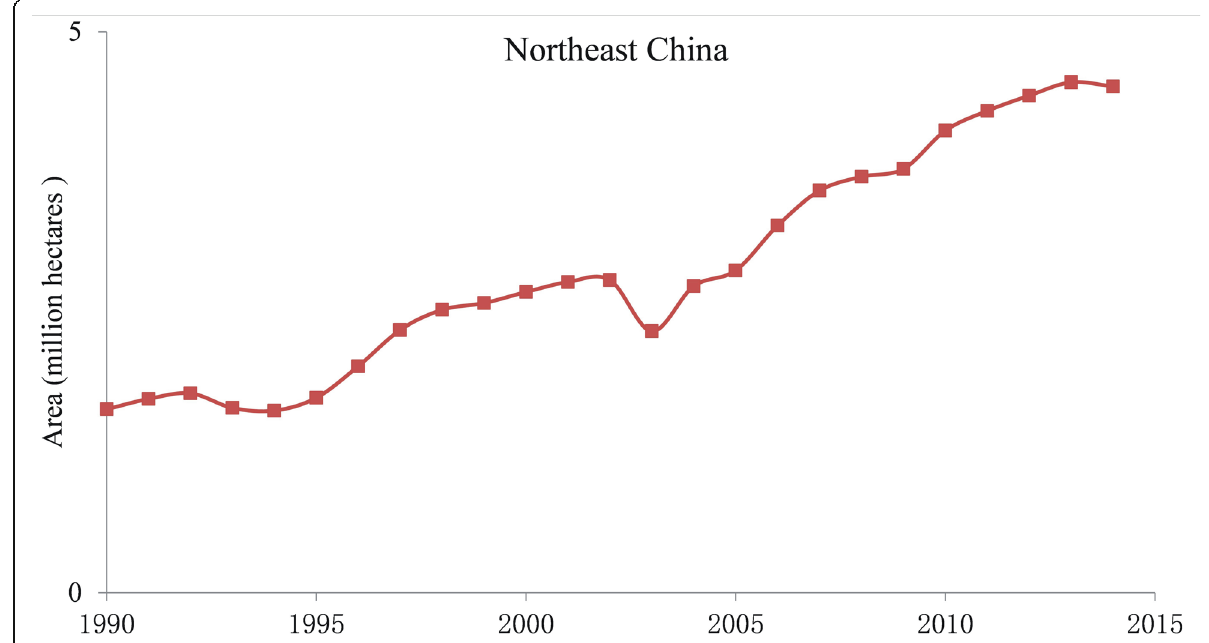
Fig. 1 The annual planting area of japonica rice in northeast China from 1990 to 2015